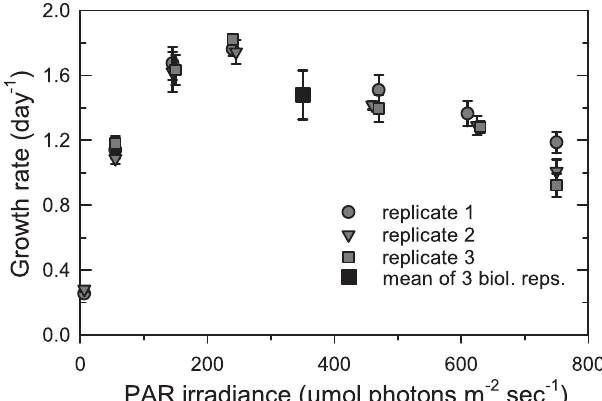
Fig 1. Growth rate as a function of photosynthetically active radiation (PAR) for light-acclimated, mid- exponential phase cultures of Micromonas commoda (RCC299). Cultures were grown in biological triplicate on a 14:10 L:D cycle. Symbols represent the mean of 3 to 5 transfers starting (cid:21) 10 generations after acclimation to the light level and error bars represent the standard error, except in two cases. For these two, data from multiple transfers post-acclimation were not available,therefore one (at 6 μ mol photonsm -2 s -1 ) has no error representedand the other (350 ± 13 μ mol photons m -2 s -1 ) shows the mean and standard deviationof the biological triplicates. At the maximum light level tested, 750 μ mol photons m -2 s -1 , the μ (0.96 ± 0.04 d -1 ) was significantly lower than at 240 μ mol photonsm -2 s -1 where μ max